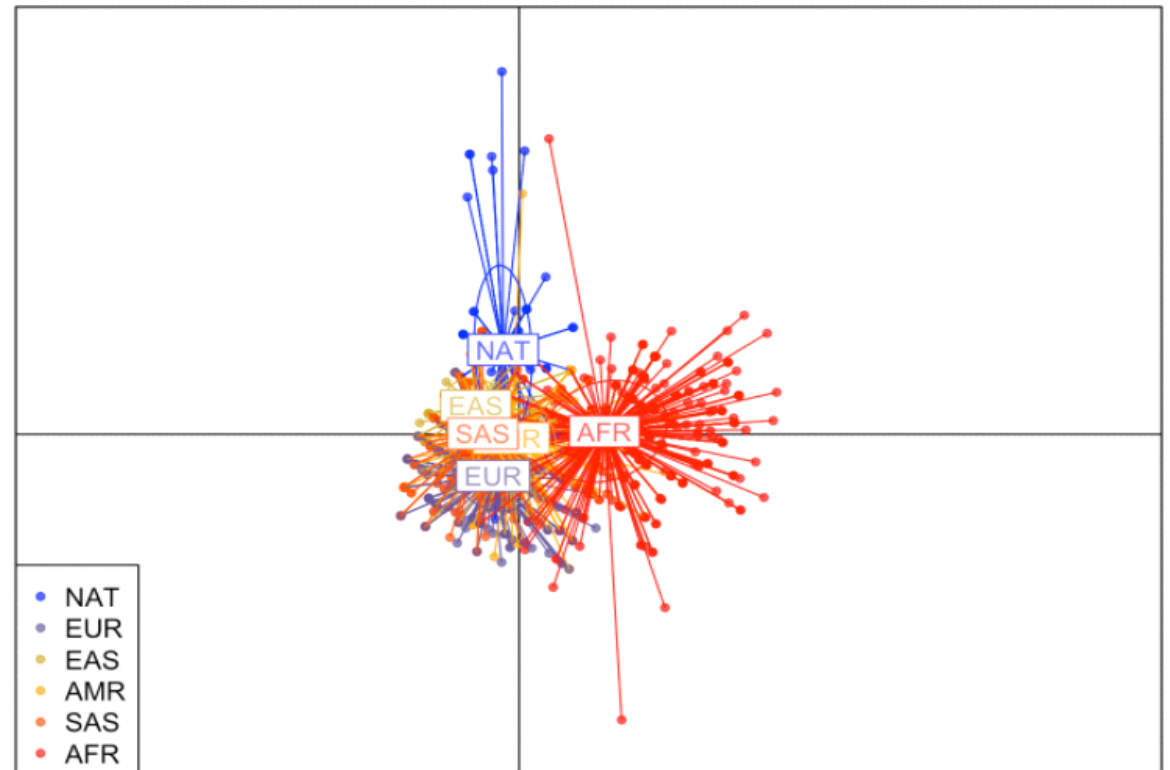
Figure 1. Discriminant Analysis of Principal Components of PCLO gene in Native American popu- lations and individuals Europe, East Asia, Americas, South Asia and Africa. Native American population (NAT), African population (AFR), European population (EUR), American population (AMR), East Asian population (EAS) and South Asian population (SAS).